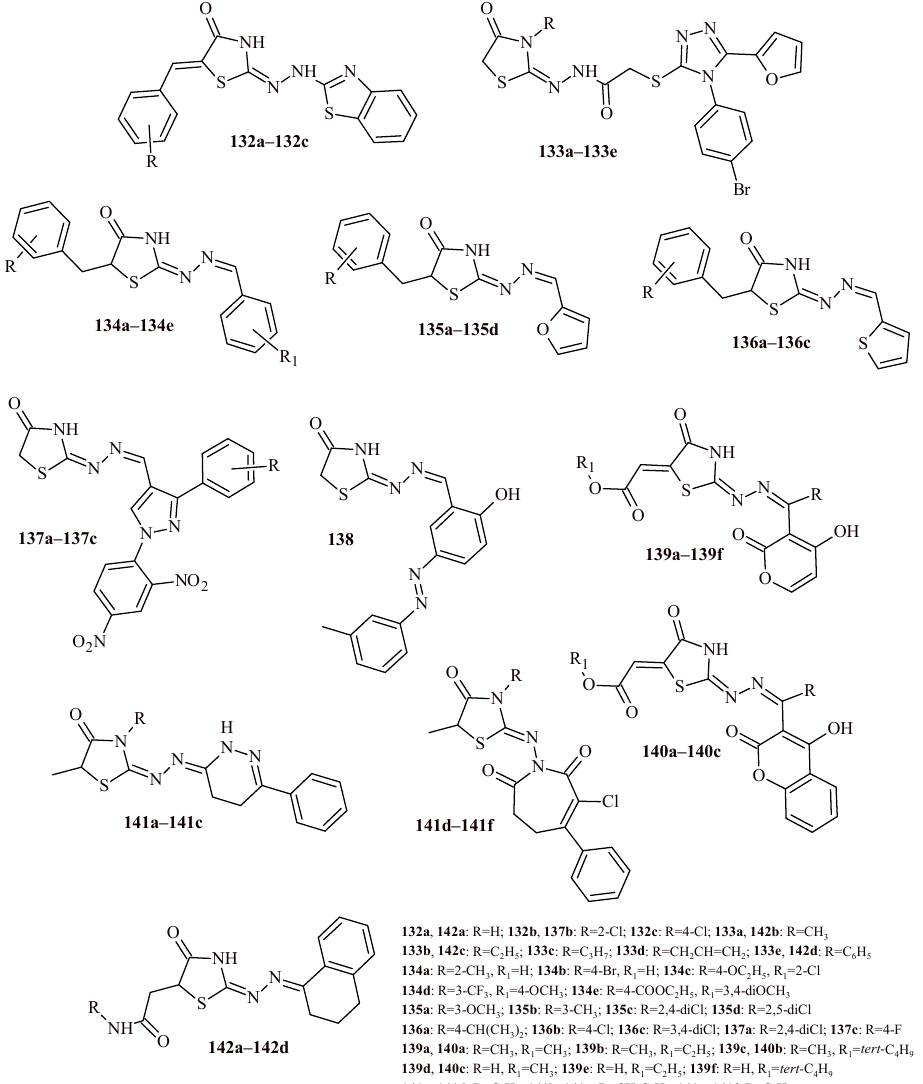
131d demonstrated comparable activity to ketoconazole against C. albicans (19–22 mm vs. 24 mm) [135]. The Compounds 132a – 132c (Figure 53) and their inclusion complex with β -cyclodextrin were tested on antibacterial activity against E. coli , S. aureus and P. vulgaris . The results showed that inclusion complex with Compounds 132a – 132c had higher activity than simple small molecules ( 132a – 132c ). For example, inhibition zones of Compound 132c were in the range of 15–16 mm, while it inclusion complex showed inhibition zone at 19–21 mm [136].